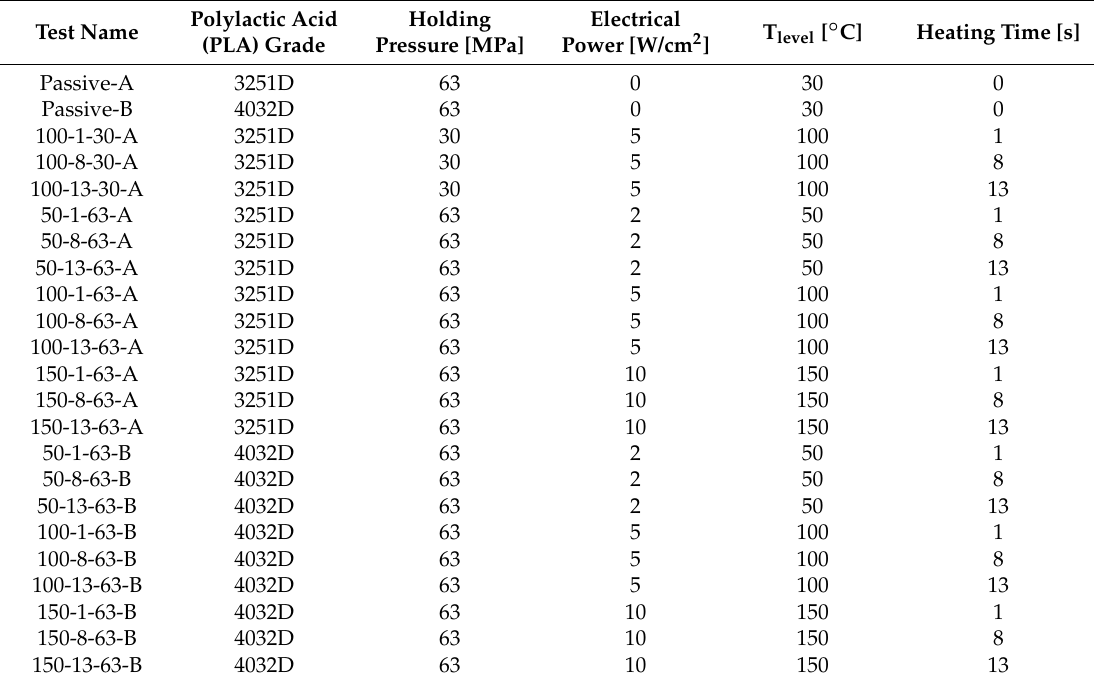
Table 1. Operating conditions adopted for the injection molding experiments with the heating device used to tune the temperature on the cavity surface (T level is the temperature reached on the cavity surface thanks to the activations of the heating